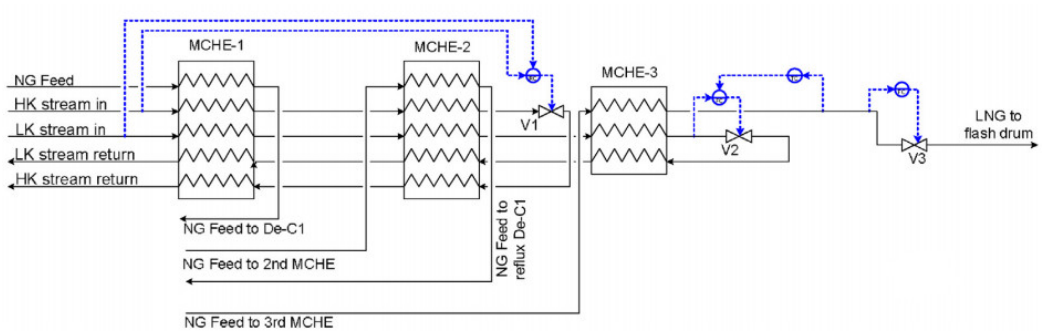
Figure 32. Arrangement of HK/LK control structure